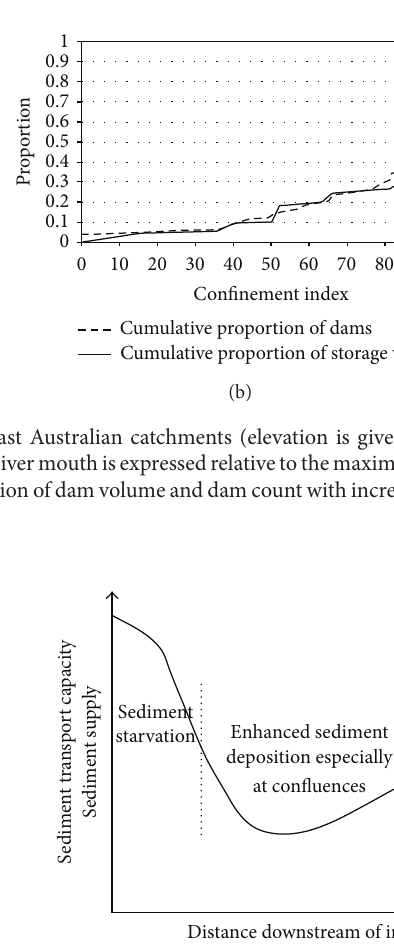
Figure 3: Conceptual model of the changes in sediment regimes downstream of dams. The 𝑥 -axis represents distance downstream from the impoundment, with the area of sediment starvation begin- ning immediately downstream of the dam wall. 𝑦 -axis represents sediment supply and transport capacity. Vertical dotted lines mark the transitions between downstream reaches dominated by different processes. Modified from [53] with